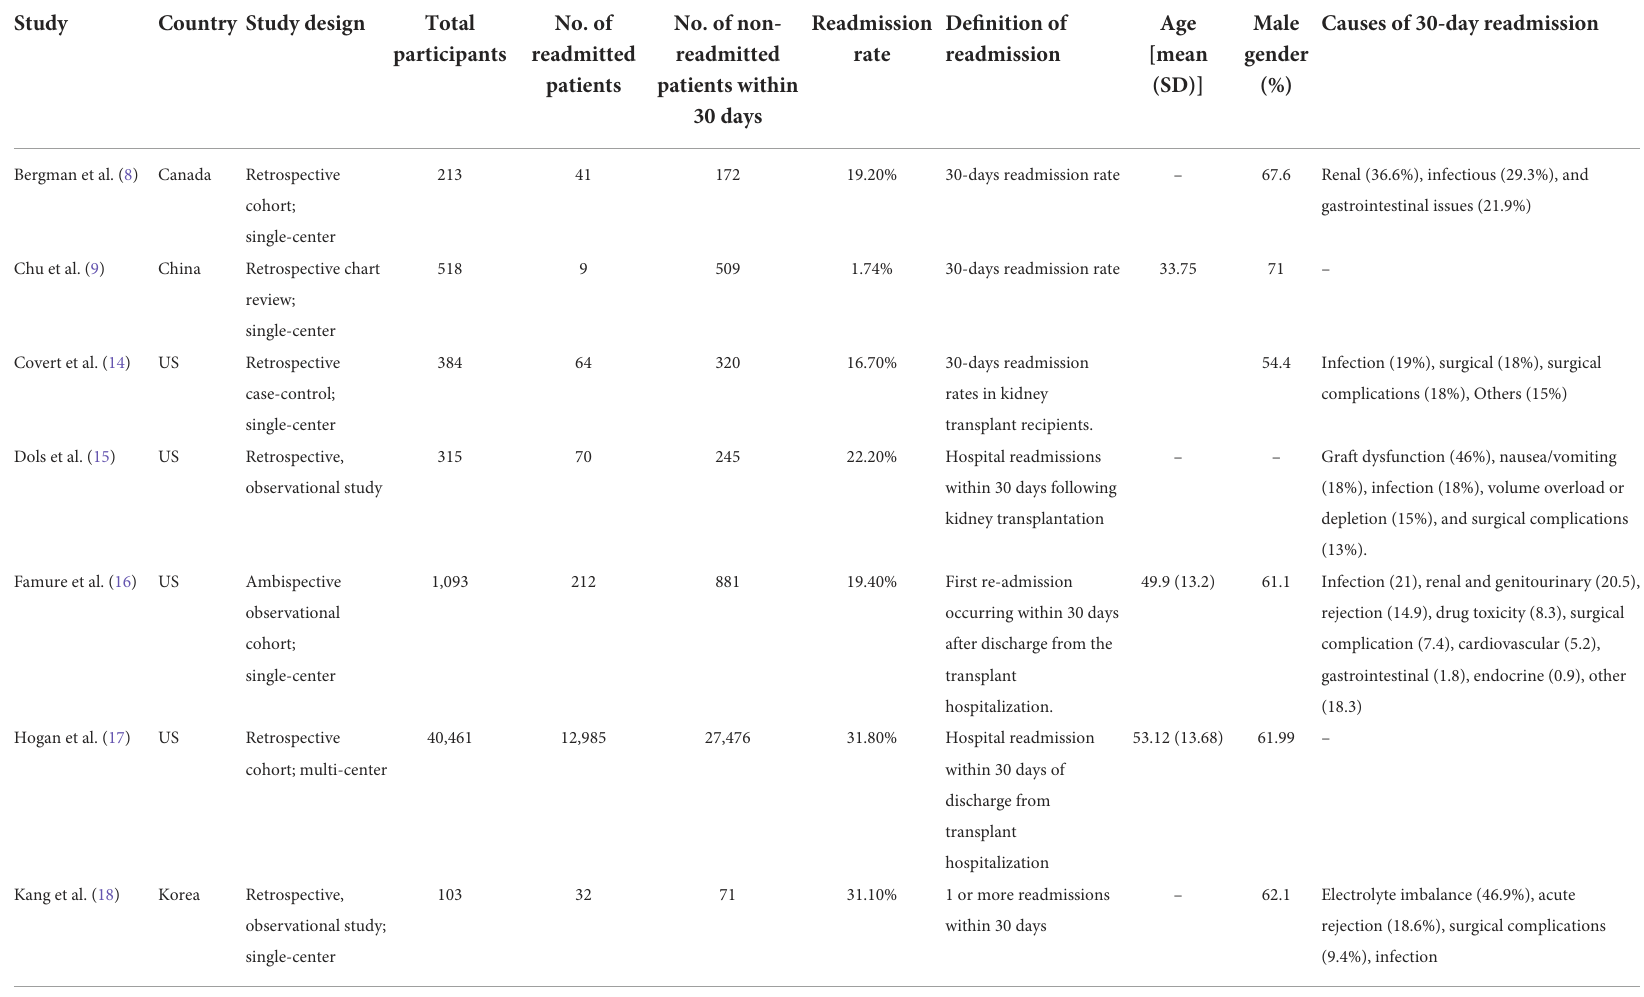
TABLE 1 Baseline characteristics of included